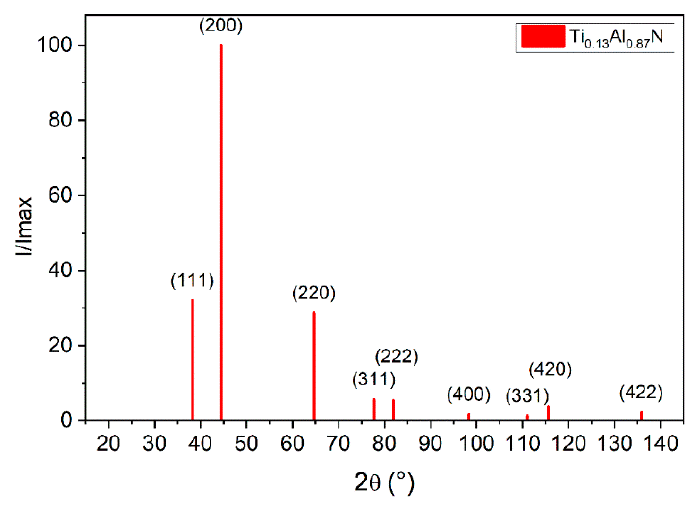
Figure 9. Extracted and normalized XRD diffractogram of the fcc-Ti 1 − x Al x N powder. Table 2. Powder diffraction data of the fcc-Ti 1 − x Al x N powder.